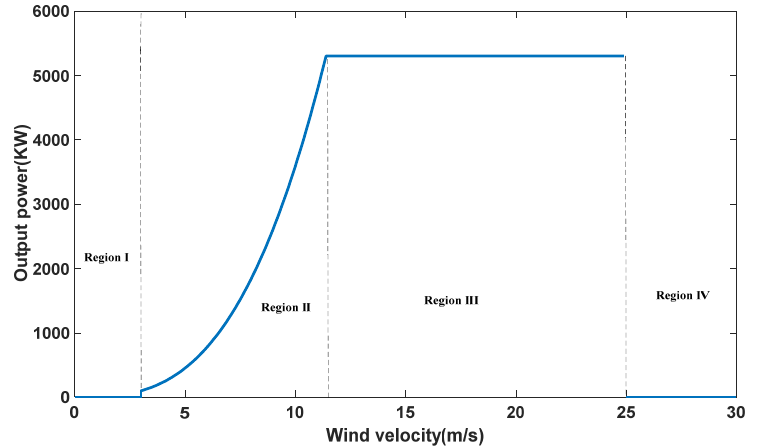
Figure 1. Different operational regions of a horizontal axis wind turbine [3].